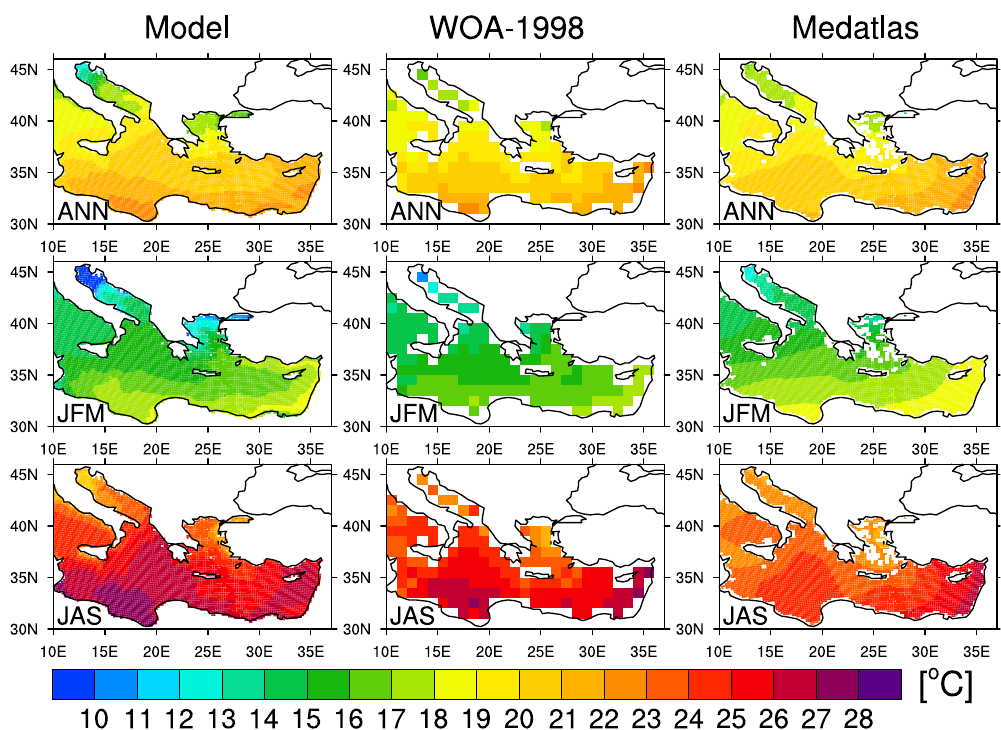
Fig. 5. Annual, winter (JFM) and summer (JAS) SSTs at 6m depth for CTRL (left), World Ocean Atlas 1998 climatology (middle) and MEDATLAS climatology